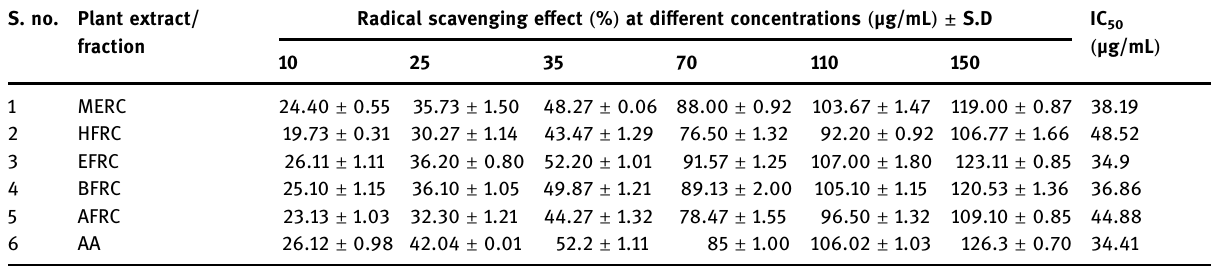
Table 1: Percent ( % ) DPPH radical scavenging activity of R. cordifolia extract/fractions and ascorbic acid ( AA ) with IC 50 values S. no. Plant extract/